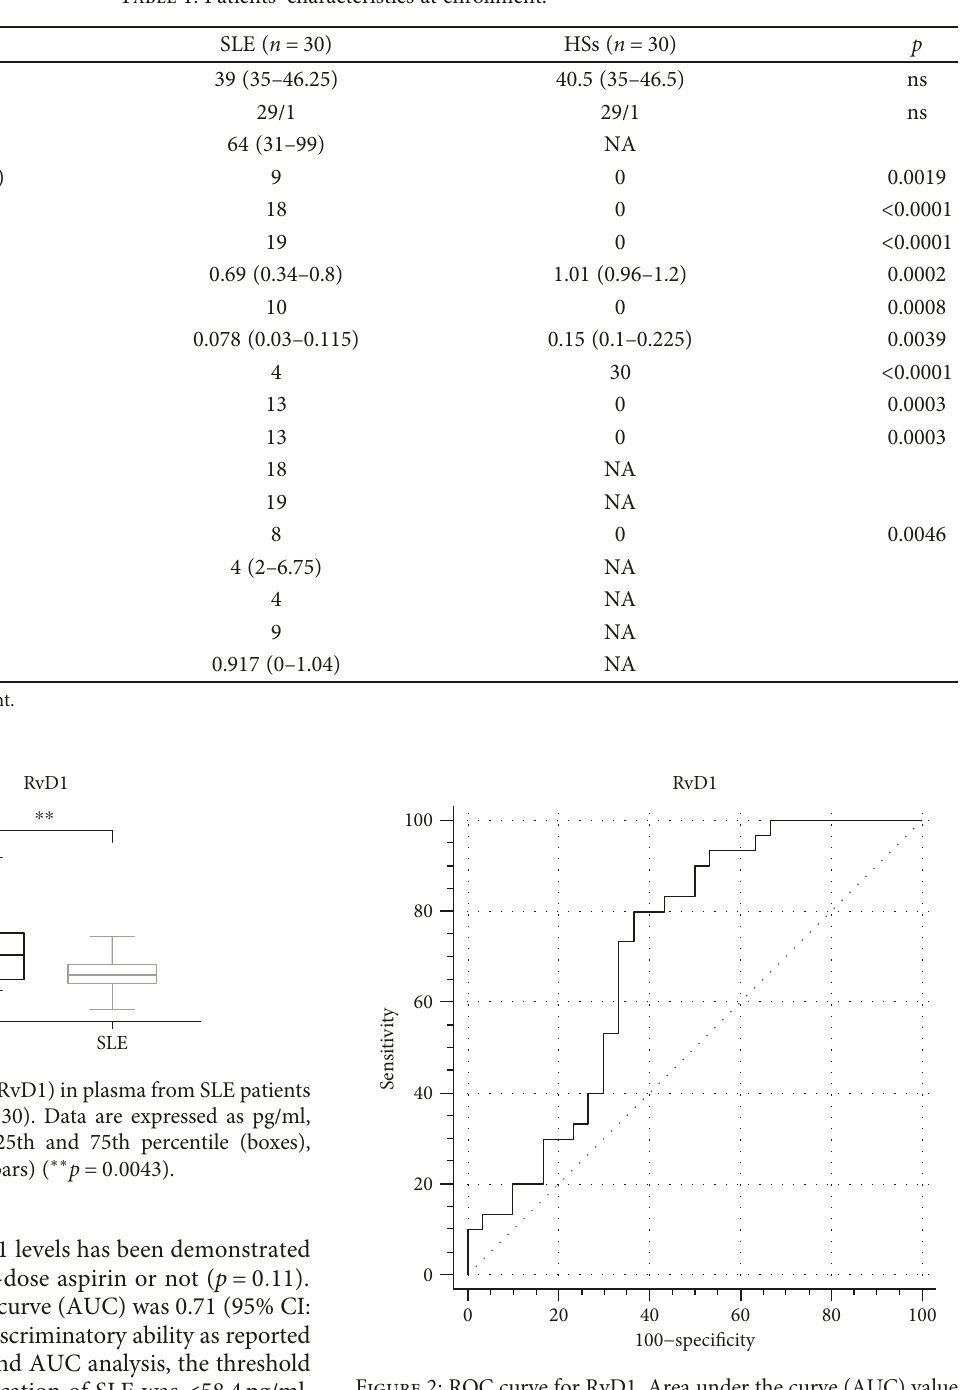
Table 1: Patients ’ characteristics at enrollment.